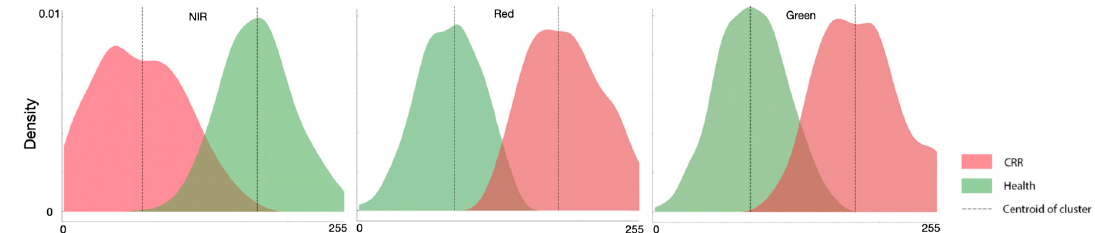
Figure 14. Spectral value distribution of CRR-infested and healthy plants.